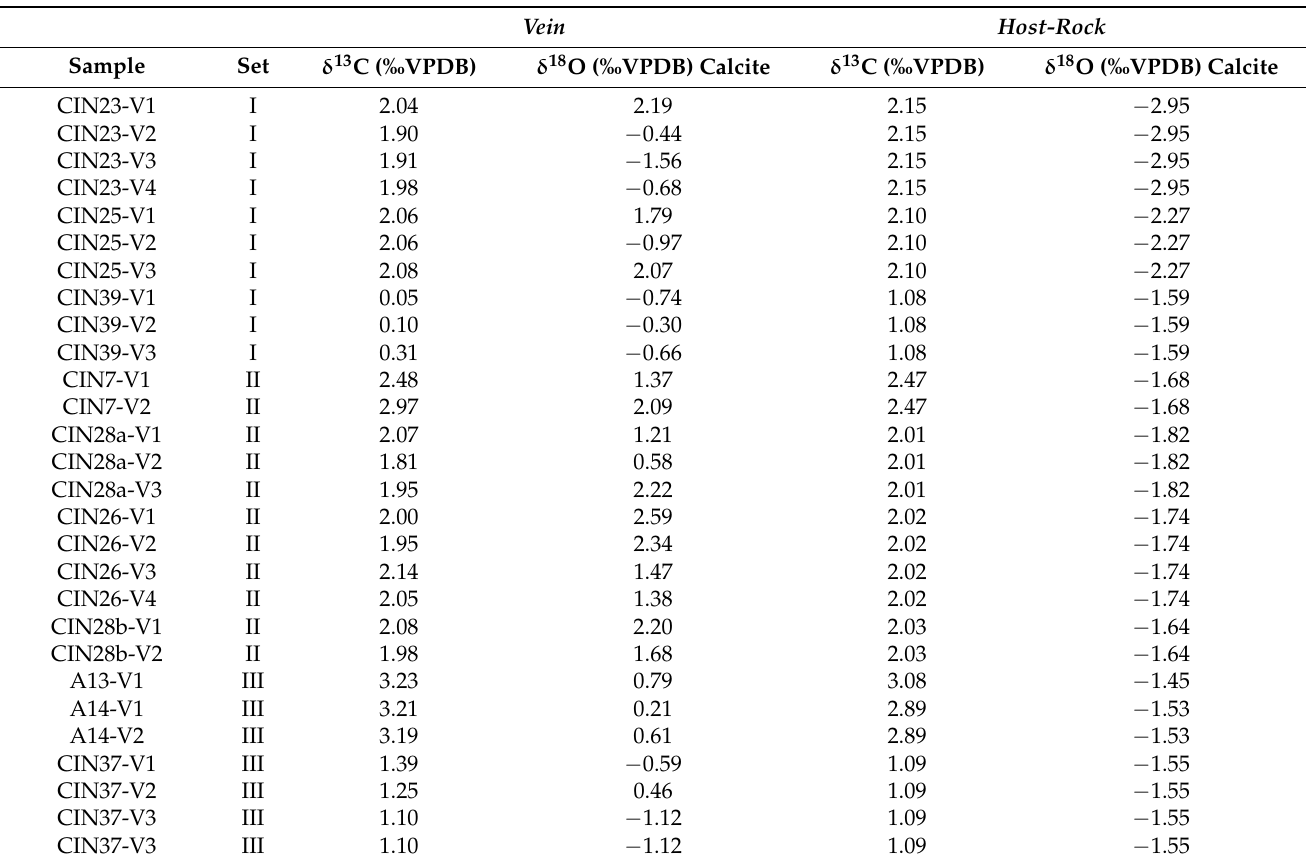
Table 2. Results of Stable Isotopic Analyses of Oxygen and Carbon Isotopes. Vein